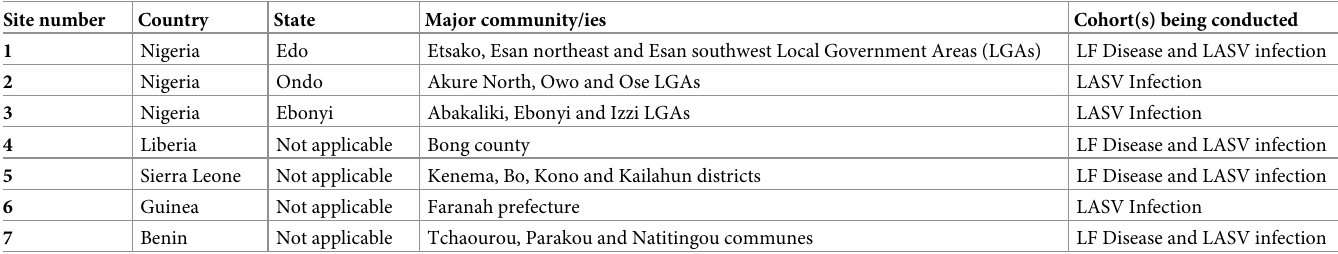
Table 3. Countries and sites where the study is being conducted and the cohorts being conducted in